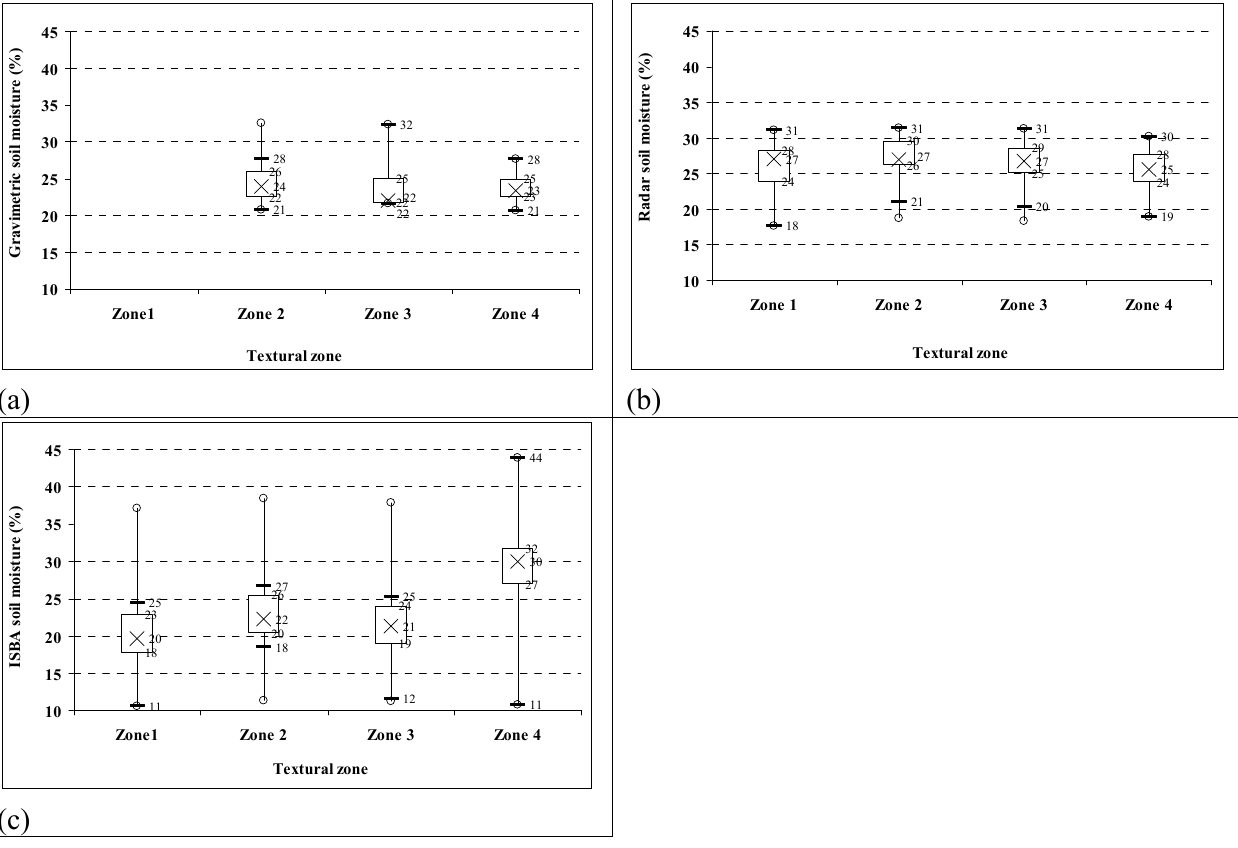
Radar estimations and gravimetric measurements of March 12, 2007 have shown that the differences of moisture observed between textural zones are not significant. The low spatial resolution of the textural map (1:1000000 scale) is not adapted to illustrate the moisture variations inside the basin. Indeed, in situ gravimetric data of 12 March 2007 show a moisture variation between the 33 test fields around 12% (moisture values between 21% and 33%), whereas at the textural zones scale the moisture variation is very weak (2%). It is then probable that the textural zones defined by the 1:1000000 map are not homogeneous and thus contain a mixture of textures. However, following